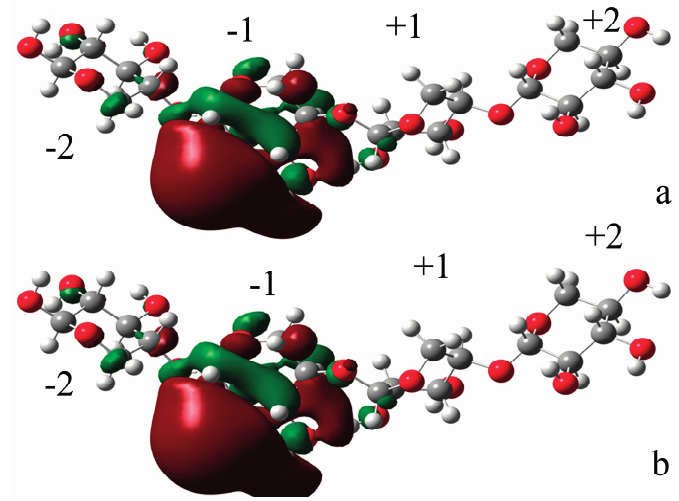
Figure 6. ( a ) The LUMO orbit of X4(sb); ( b ) The LUMO orbit of